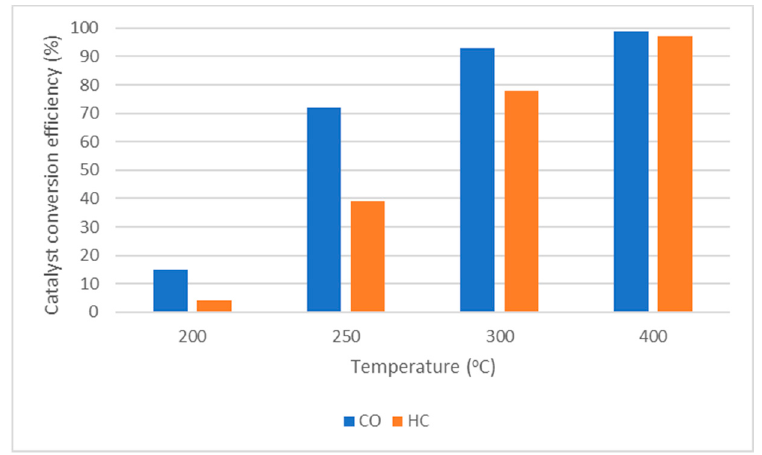
Figure 6. Conversion efficiency for CO and HC as a function of temperature for a typical oxidizing catalytic converter. Adapted from [50].